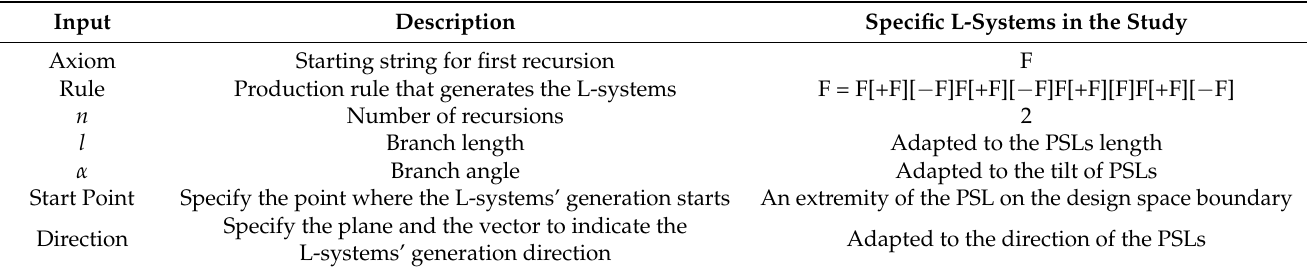
Table 2. Grammar of the L-systems used in the biomimetic design